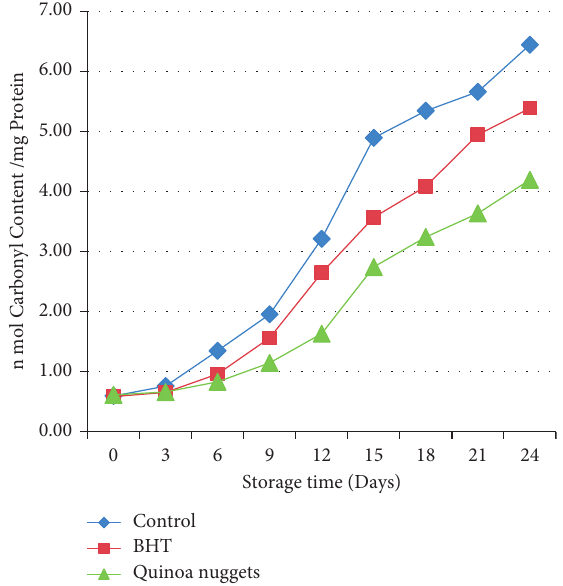
Figure 2: Protein oxidation (DNBH) (nmol carbonyl content/mg protein) of chicken nugget samples during storage at 4 ° C for 24